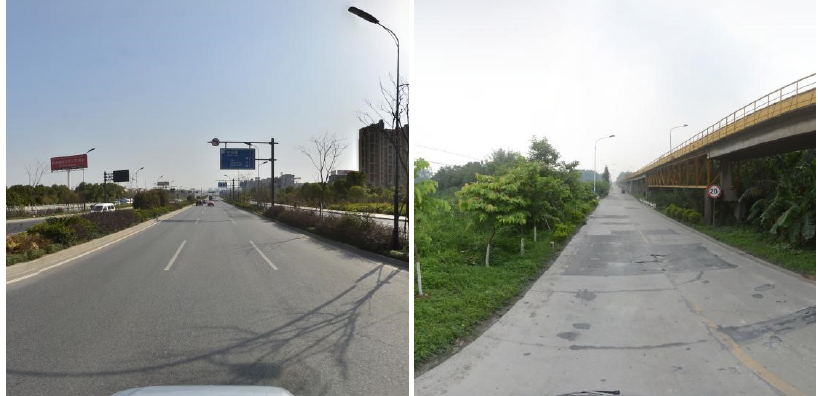
Figure 4. Images in